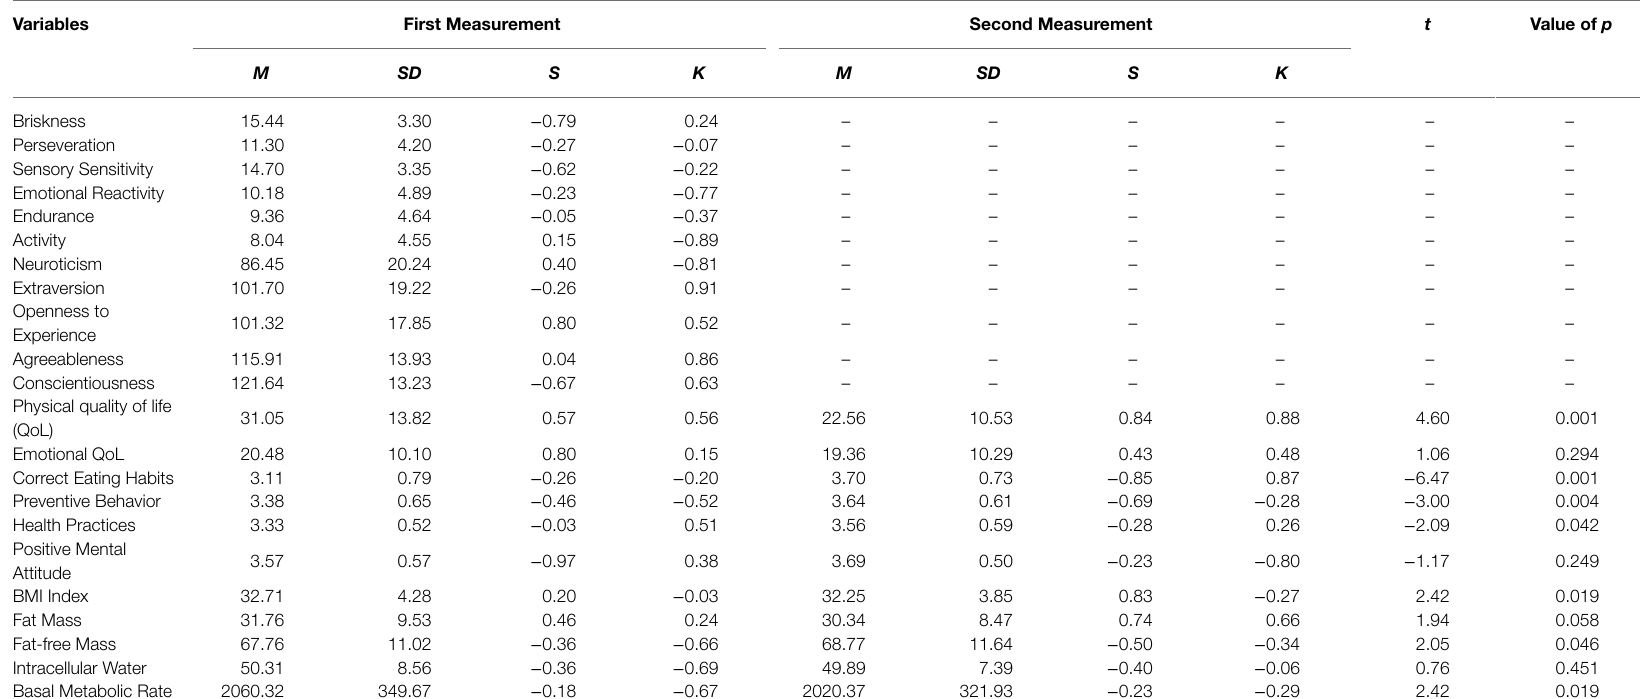
TABLE 2 | Descriptive statistics for analyzed variables acquired in the first and second measurements with the values of statistical tests for differences. Variables First Measurement Second Measurement t